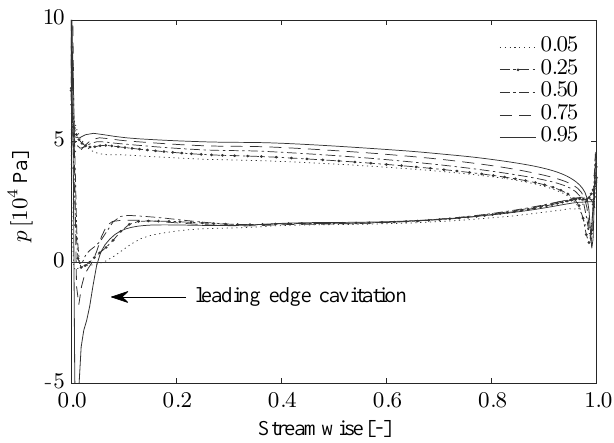
Fig. 5. Pressure on blades of a premature runner at different spans